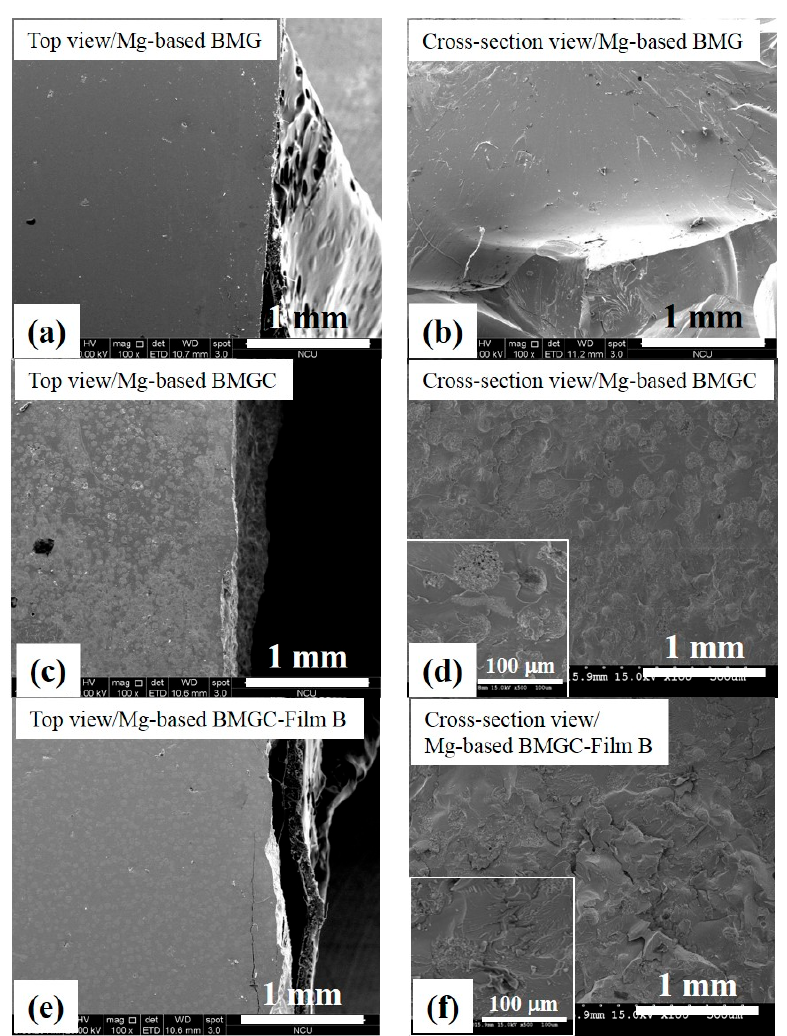
Figure 7. SEM images of the fracture edges and fracture surfaces for the samples after bending tests. ( a ) and ( b ) are the Mg-based BMG; ( c ) and ( d ) are the Mg-based BMGC; ( e ) and ( f ) are the Mg-based BMGC with Zr-based MGTF coating. Each insert in ( d,f ) is the enlarged image from the circle area of each figure.